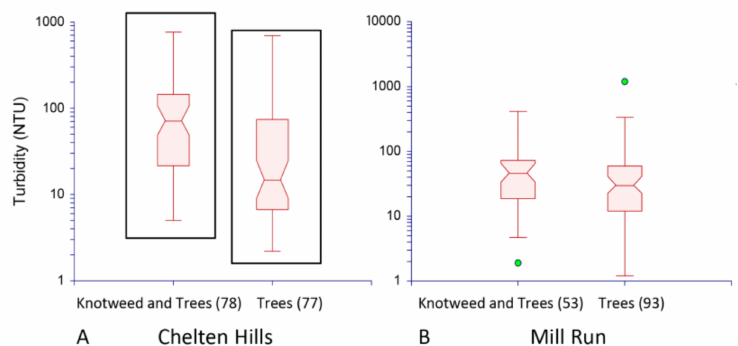
Figure 9. Turbidity response by vegetation. Outlined box plots indicate a statistical difference. When loggers were separated by vegetation type there was a statistical difference between mixed vegetation and trees only at Chelten Hills ( A ) but no statistical difference between the vegetation types at Mill Run ( B ). The logger site with trees at Chelten Hills was also highly incised.